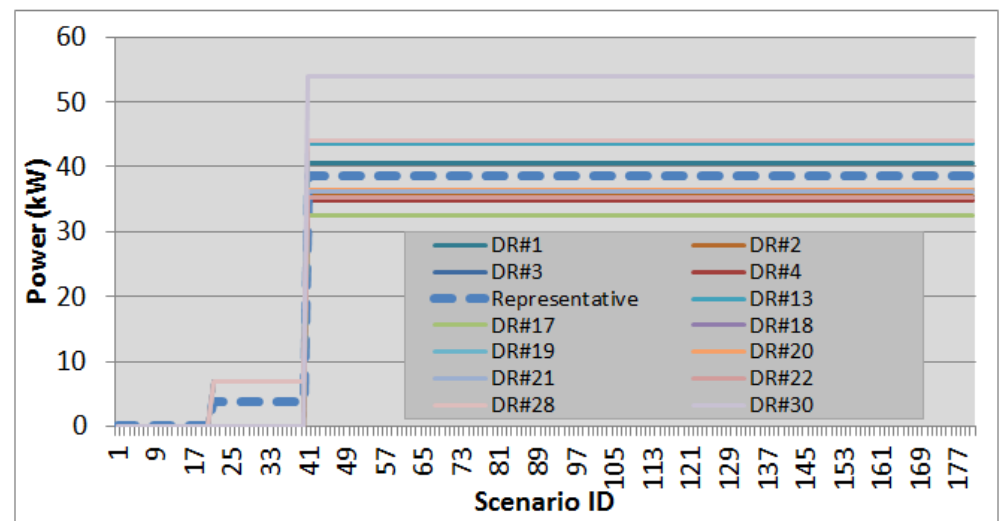
Figure 8. Resources profiles in Cluster 4, in the energy